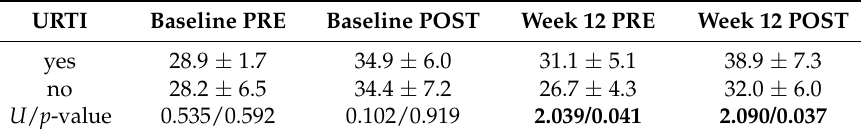
Table 4. Association between upper respiratory tract infection (URTI) incidence at week 12 and degree of tryptophan breakdown as indicated by Kyn/Trp (mean ± SEM). Bold text indicates a statistically significant correlation with a p ‐ value less than 0.05.